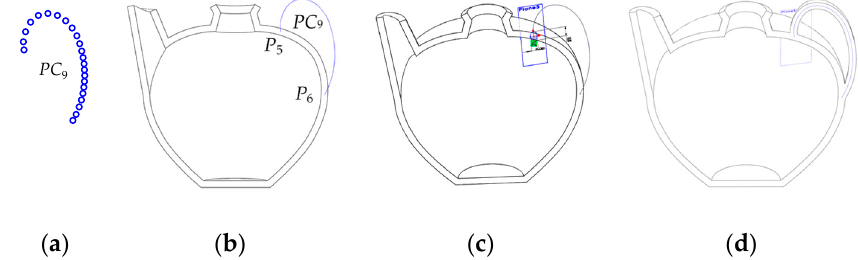
Figure 19. Solid CAD modeling of the ewer handle. ( a ) Point cloud of the handle; ( b ) point cloud of handle injected into the solid CAD model; ( c ) reference plane and ellipse to construct handle; ( d ) result of handle construction.